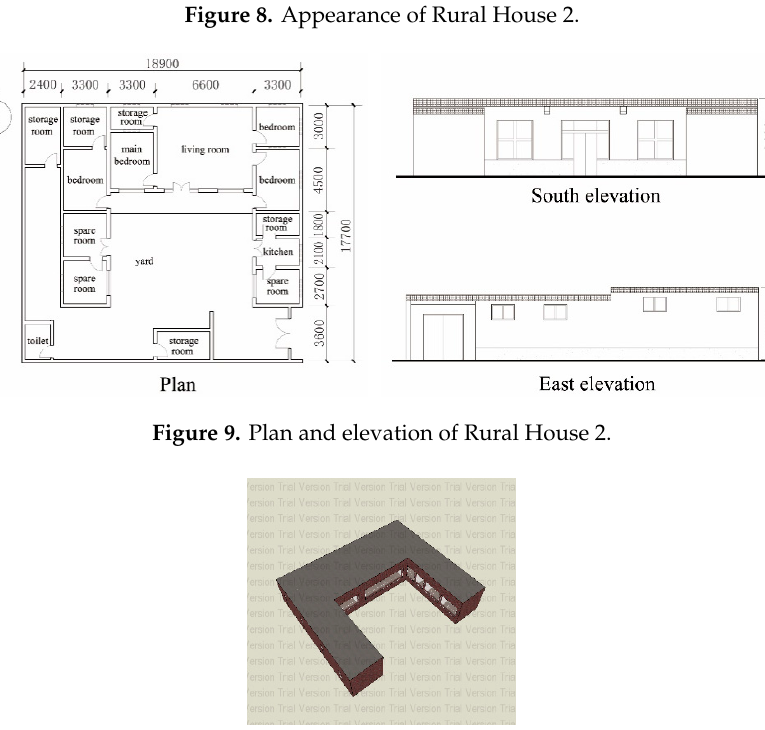
Figure 10. Architectural analysis model.